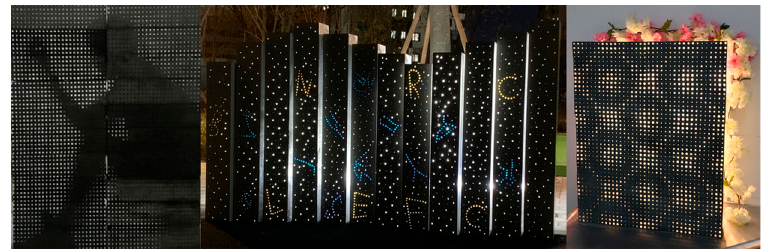
Figure 2. Examples of transparent plastic bar reinforced concrete.